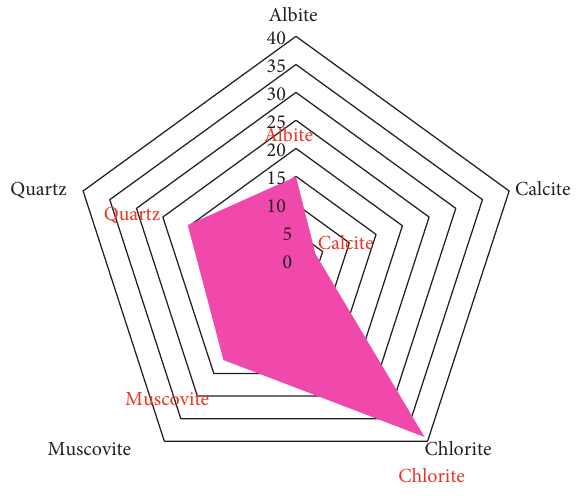
Figure 2: Mineral components.